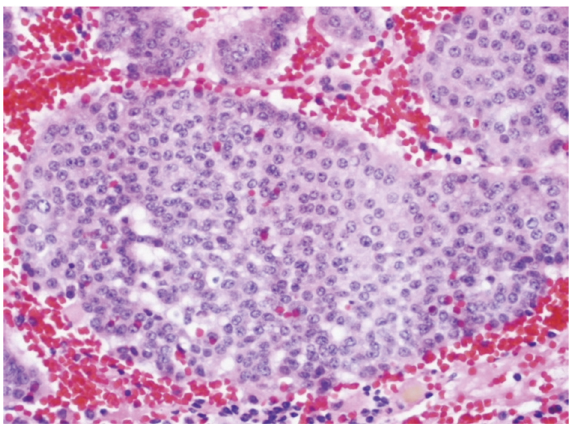
Figure 5: Histology showed a mass composed of trabeculae and solid nests of round, monotonous cells with crowded nuclei and stippled, open chromatin consistent with a cystic well-differentiated neuroendocrine tumor. Few mitotic figures were identified within the